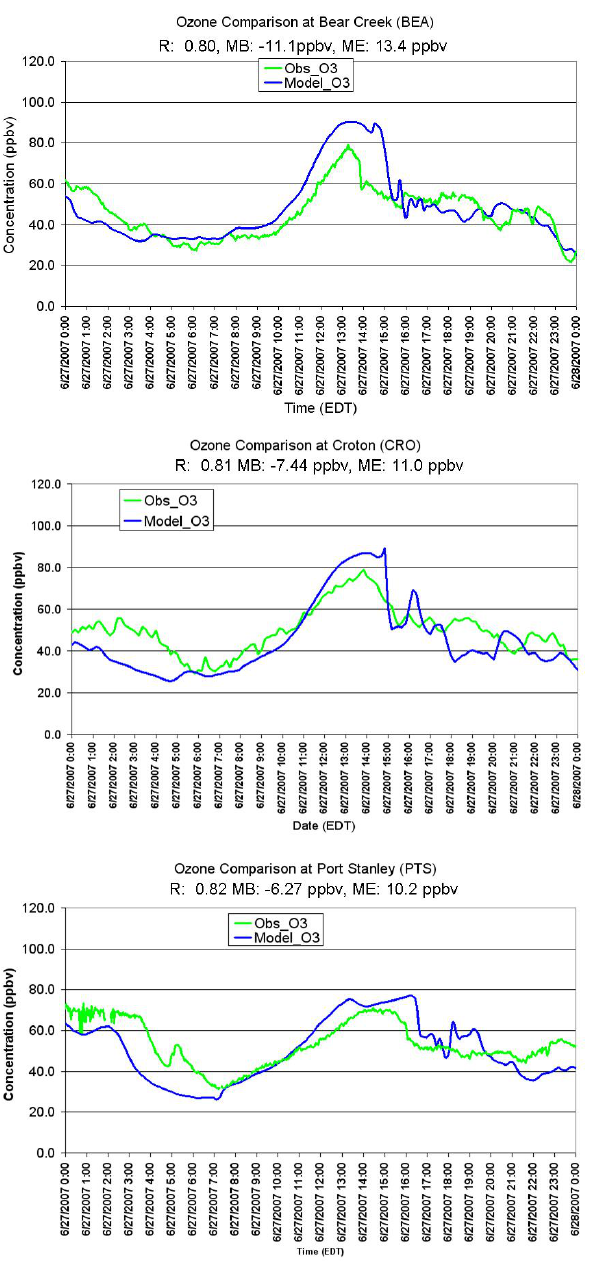
Fig. 15. Model-predicted surface ozone and wind fields for 27 June at (a) Croton, (b) Bear Creek, (c) Port Stanley. Statistical measures are for the entire measurement intensive, at each site.